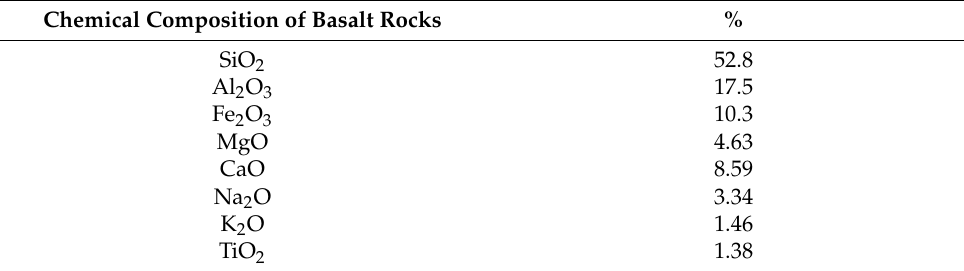
Table 2. Chemical composition of the basalt fiber